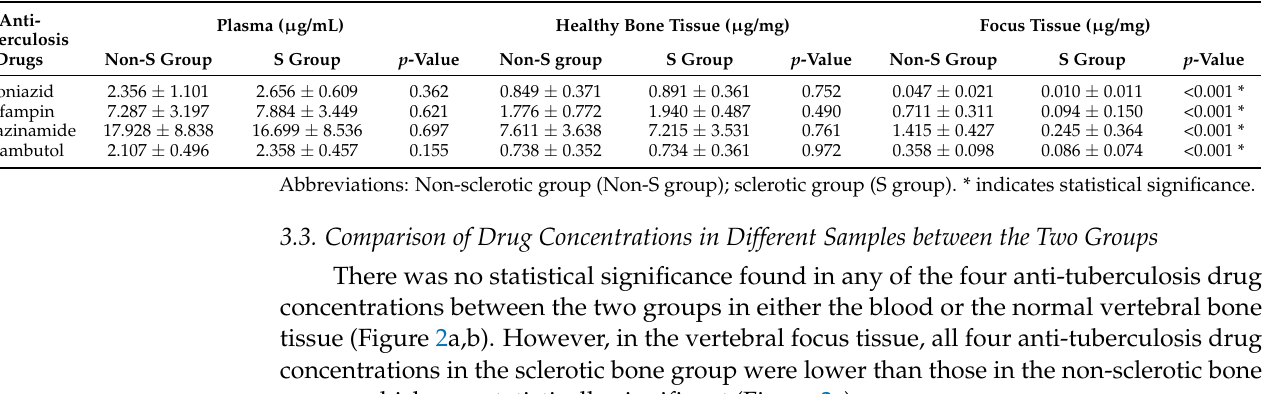
Table 2. The comparison of anti-tuberculosis drug concentrations in plasma, healthy bone tissues, and the focus between the sclerotic bone group and the non-sclerotic bone group.